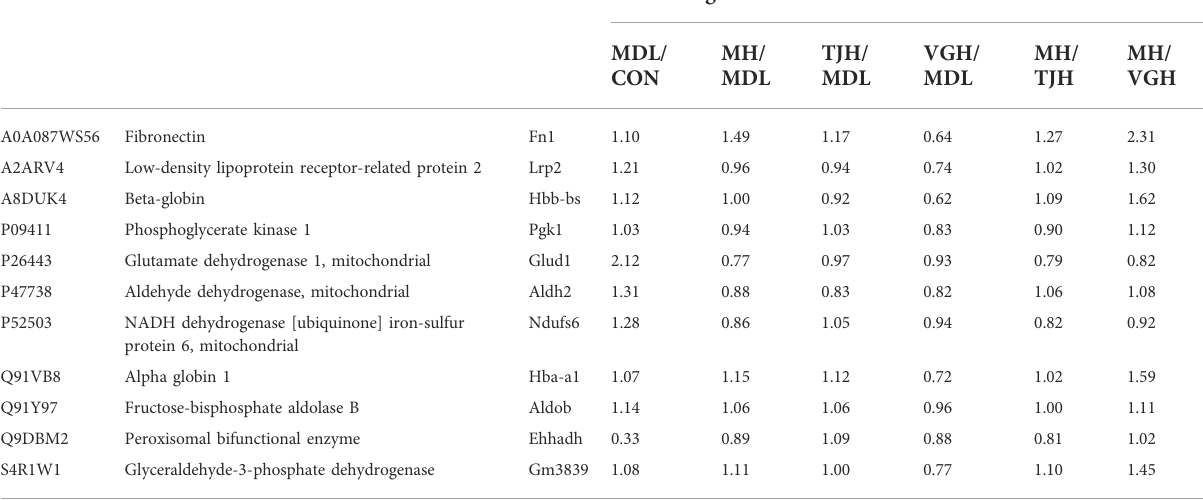
TABLE 4 Relative quantitative results of target proteins. Protein ID